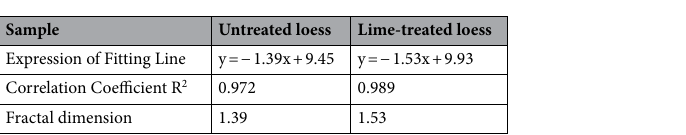
Table 4. Distribution fractal dimension of pores in untreated loess and lime-treated loess.